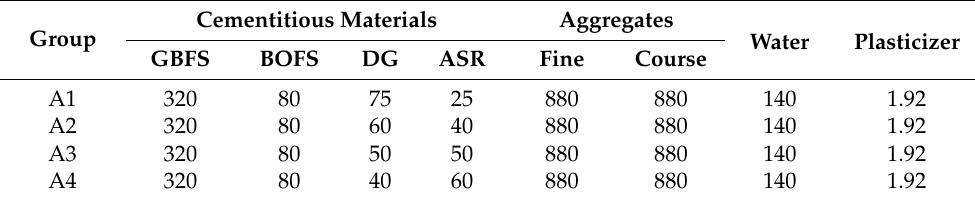
Table 2. Mix proportion of the concrete (kg/m 3 ).